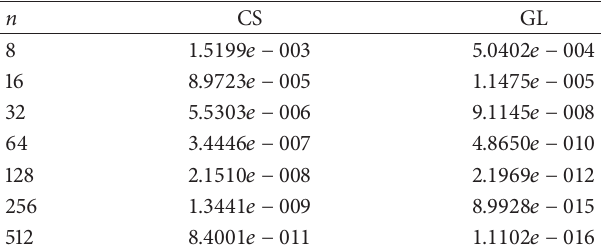
Table 4: Errors of integration ∫